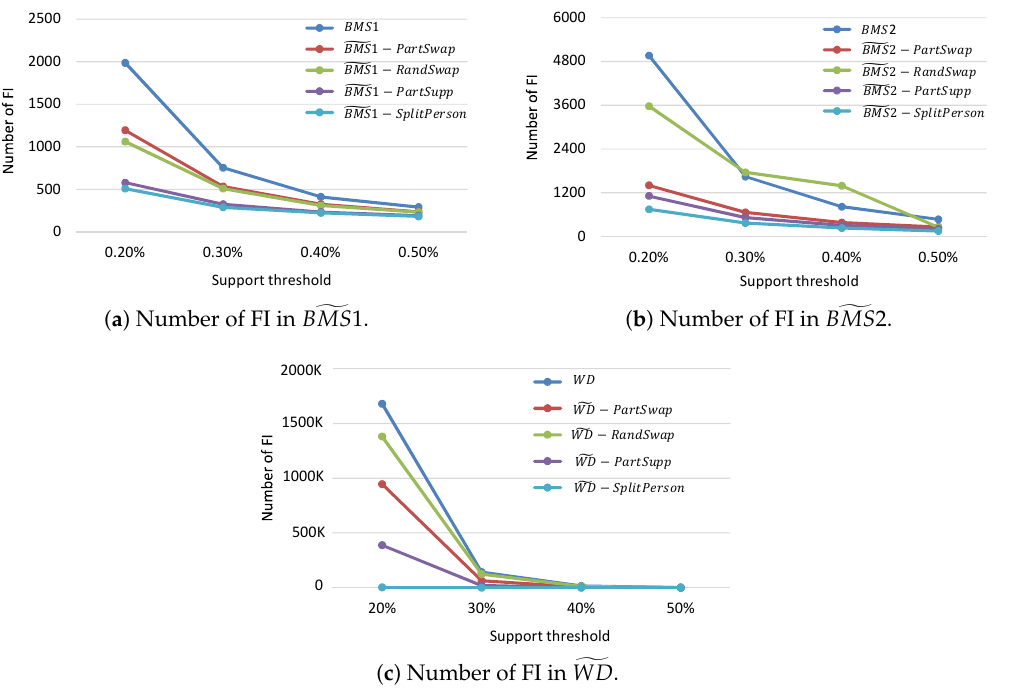
Figure 3. Comparison of the number of frequent itemset in anonymized datasets and original